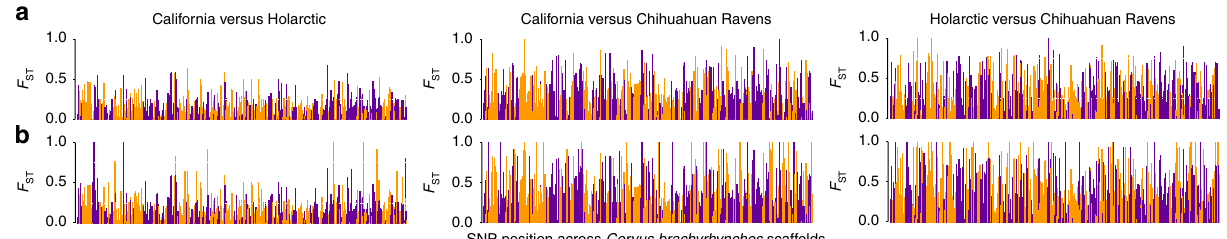
Fig. 4 Genome-wide patterns of divergence between North American raven lineages. Manhattan plots show mean pairwise F ST for each SNP estimated between each lineage using data sets that either a excluded ( n = 2689 SNPs) or b included ( n = 2969 SNPs) SNPs that violated Hardy – Weinberg equilibrium (HWE). Scaffolds are ordered numerically across the Corvus brachyrhynchos genome and neighbouring scaffolds are identi fi ed by alternating